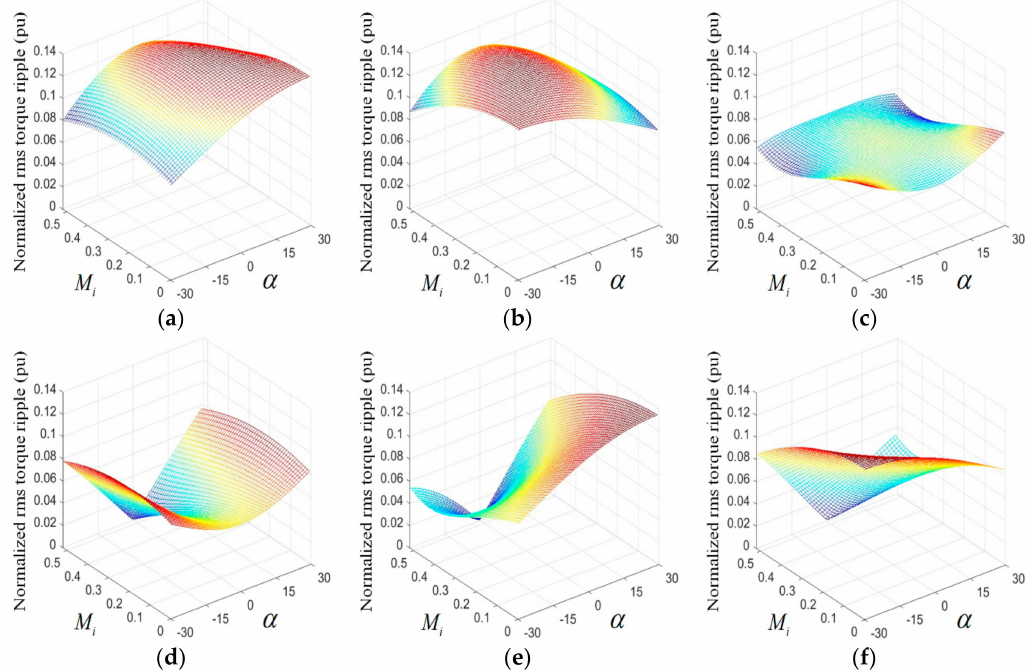
Figure 5. Analytical results of normalized root mean square (RMS) torque ripple over a subcycle.